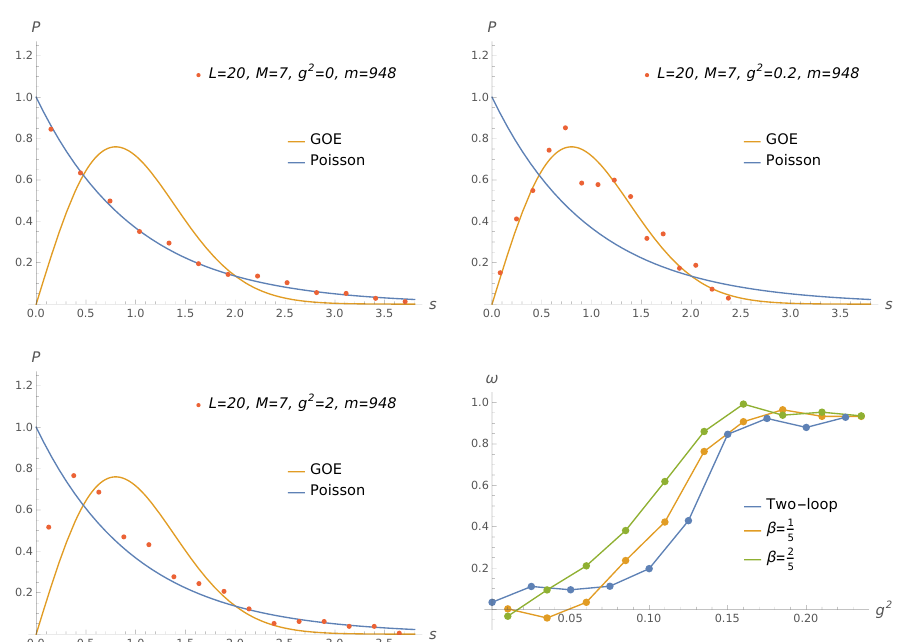
Figure 1 . Distribution of level spacings of the two-loop spin chain for positive-parity primary operators with L = 20 and M = 7 for g 2 = 0 , 0 . 2 , 2 (top left, right and bottom left). The Wigner- Dyson distribution with α = 1 and the Poisson distribution are shown for comparison. Bottom right: Brody-distribution parameter ω as a function of g 2 for zero-momentum states with L = 20 , M = 7 and for the twisted deformation with β = 1 / 5 and β = 2 / 5